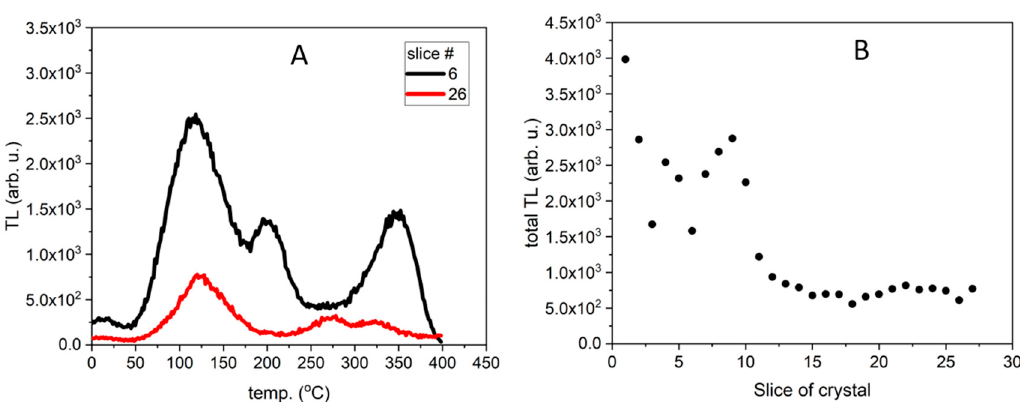
Figure 2. TL signal of LMP doped with 0.8-mol% Tb: ( A )—TL glow curve for slice #6 is typical for the curves for slices 1–12, curve for slice #26 is typical for the curves for slices 13–27. ( B )—Integrated TL signal in the temperature range between 20 °C and 400 °C calculated for all TL curves. The samples were irradiated with 0.2 Gy of beta rays in the Risø reader. Slice of crystal—numbers represent labelling of samples along the crystal length, as illustrated in Figure 1.